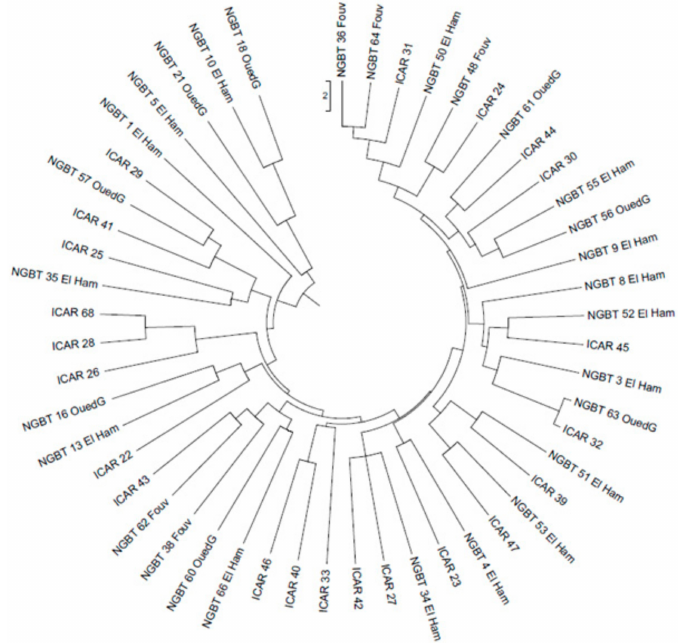
Figure 3. Dendrogram of faba bean collection split in samples collected by the National Gene Bank of Tunisia (NGBT) and Agricultural Research in the Dry Areas (ICAR) resulting from the UPGMA cluster analysis based on similarity matrix obtained from 11 SSR allelic